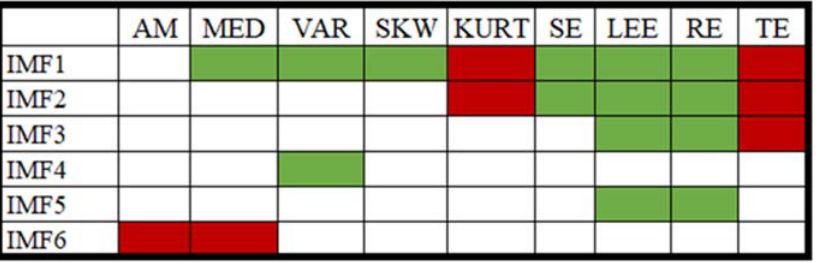
Figure 6. List of features that showed a significant change in different IMFs (note: : a significant decrease in value post-consumption of coffee, : a significant increase in value post-consumption of coffee, no color: insignificant change in value post-consumption of coffee). Table 1. Classification performance of the best ML models generated from the EMD-based processing of the ECG signals at different decomposition levels.